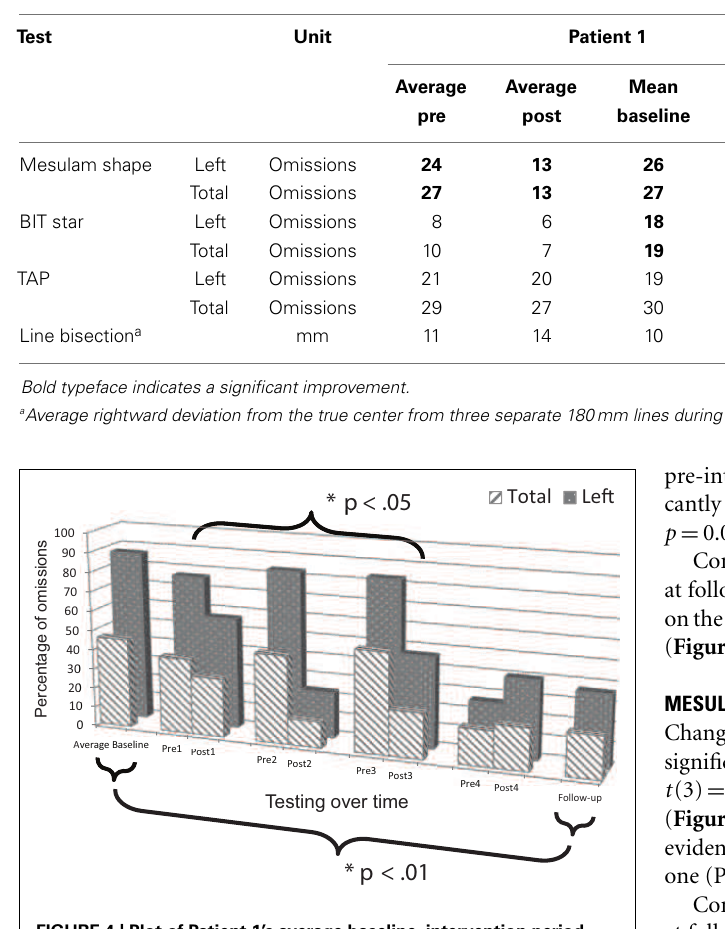
FIGURE 4 | Plot of Patient 1’s average baseline, intervention period, and follow-up responses on the Mesulam shape cancellation test